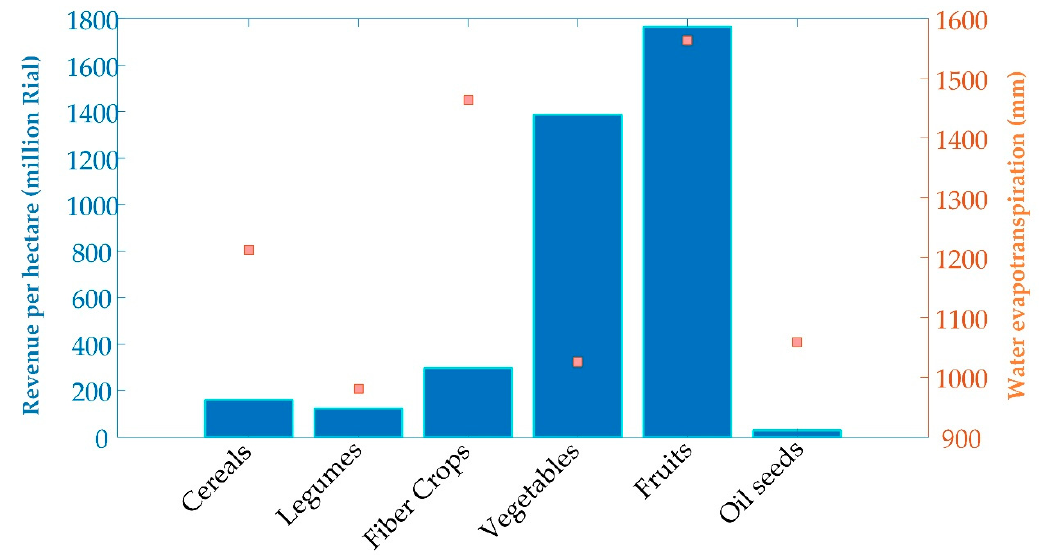
Figure 5. (a) The fractional contribution of exports, and (b) imports of the province during 2005–2014 Figure 5. ( a ) The fractional contribution of exports, and ( b ) imports of the province during 2005–2014 (1143.53 Mm 3 is imported and 274.97 Mm 3 is exported at the province level). (1143.53 Mm 3 is imported and 274.97 Mm 3 is exported at the province level).